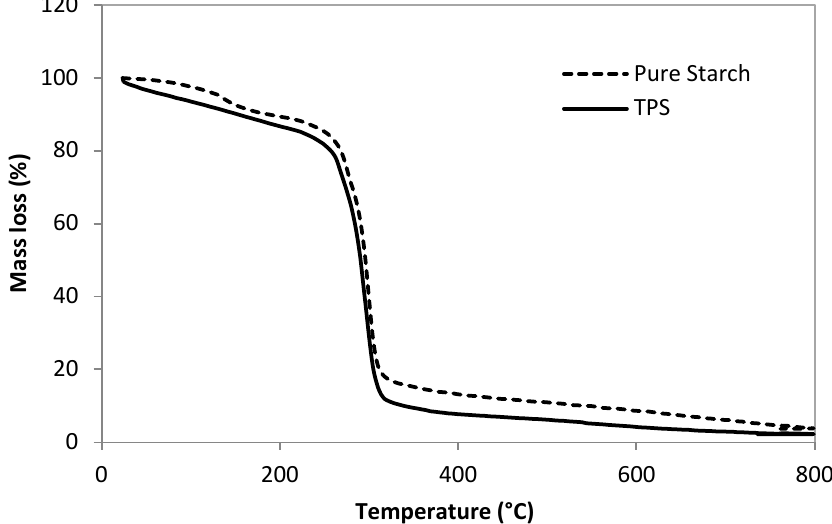
Figure 10. Thermogravimetry analysis (TGA) for native starch and TPS.